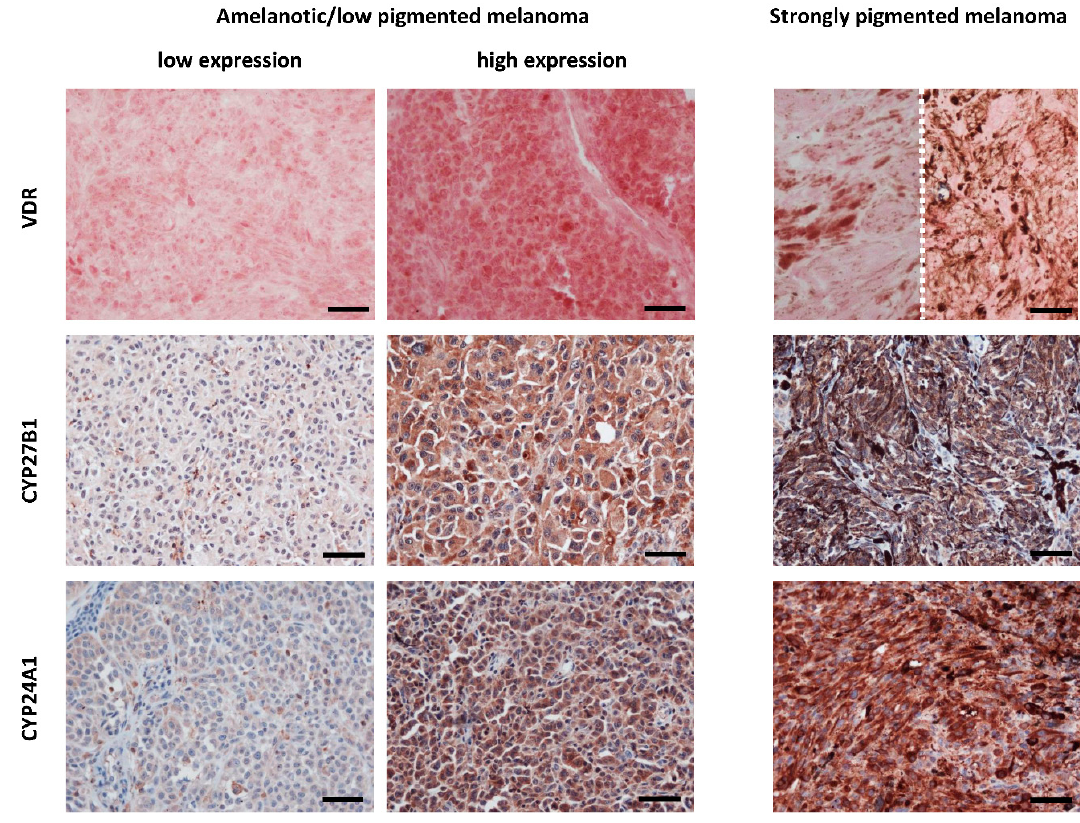
Figure 1. VDR, CYP27B1 and CYP24A1 immunostaining cutaneous melanomas. Left panel presents lack or low VDR, CYP27B1 and CYP24A1 expression in amelanotic / low pigmented human melanomas obtained from tissues of patients treated in Oncology Center, Bydgoszcz, Poland. Middle panel presents high expression of VDR, CYP27B1 and CYP24A1 expression in amelanotic / low pigmented melanomas. Right panel presents VDR, CYP27B1 and CYP24A1 expression in strongly pigmented melanomas (images of VDR from two di ff erent cases are separated with dotted line). VDR was labelled with rat antibody (clone 9A7; Abcam, Cambridge, MA, USA; a dilution 1:75) and visualized with Red AP Substrate (Vector Laboratories, Burlingame, CA, USA). CYP27B1 and CYP24A1 were labelled with rabbit antibody (clone H-90, Santa Cruz Biotechnology, Santa Cruz, CA, USA, a dilution of 1:75) and mouse antibody (Abcam, Cambridge, UK, dilution 1:40), respectively, followed by visualization with ImmPACT NovaRED substrate (Vector Laboratories, Burlingame, CA, USA) and counterstaining with hematoxylin [23,143,144]. Scale bars : 50 μ m. Various polymorphisms of VDR have also been found to affect the risk and prognosis of melanoma, but a consistent pattern has not been identified [141]. Orlow et al. first studied 38 common VDR single-nucleotide polymorphisms (SNPs) and discovered six of these to be associated with increased risk of melanoma development and two with decreased risk [145]. In a later study by the same group, eight SNPs were found to be associated with improved survival in melanoma [146]. Furthermore, the impact of various SNPs on melanoma survival also depends on the amount of sun exposure around time of melanoma diagnosis [147]. However, a 2009 study analyzing six VDR SNPs found no significant change in outcomes with the exception of worse outcome in patients with the BsmI polymorphism and low vitamin D levels [148]. Overall, the understanding of VDR variants in melanoma remains poor [149]. Recently, VDR has also been proven to exist in uveal melanocytes and melanomas as well. While VDR expression was not found to be associated with histopathological characteristics of uveal melanoma, an inverse correlation was shown between expression level and the degree of tumor pigmentation [150]. In light of the positive correlation between uveal tumor pigmentation and